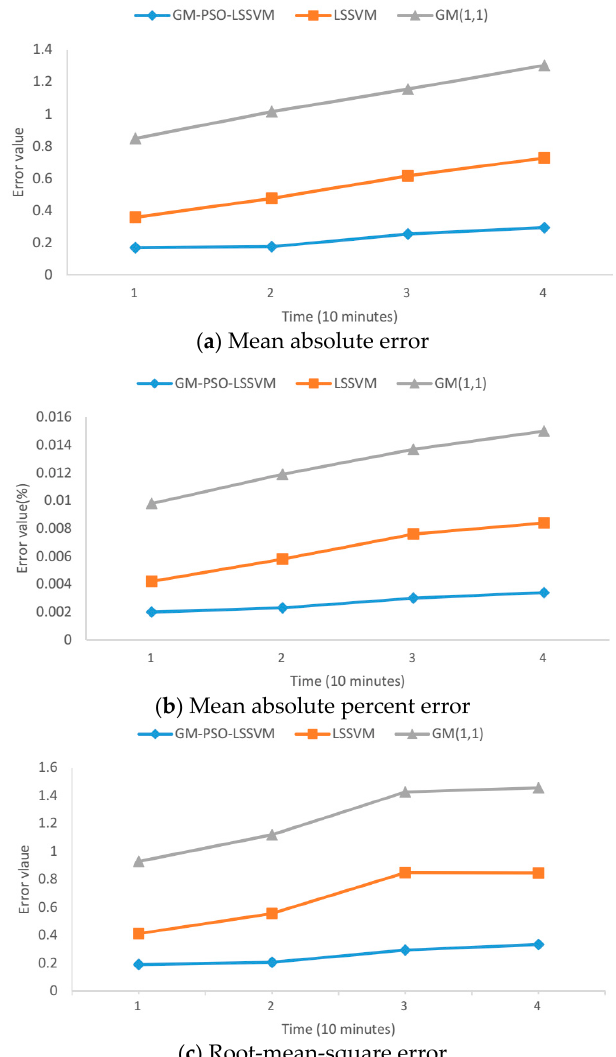
Figure 8. The error of the forecasting ( a ) mean absolute error (MAE); ( b ) mean absolute percent error (MAPE); ( c ) root-mean-square error (RMSE).